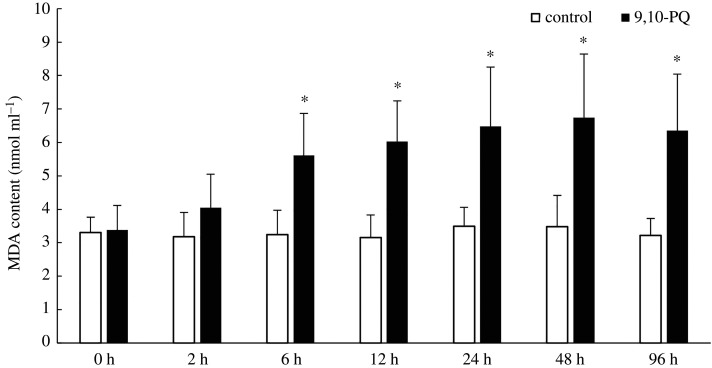
MDA content in plasma of T. obscurus under sublethal exposure to 9,10-PQ. The data indicate mean (nine fish samples from three aquaria) and s.d. Significant differences (p < 0.05) between control and 9,10-PQ treatment are marked by asterisks (Student's t-test).